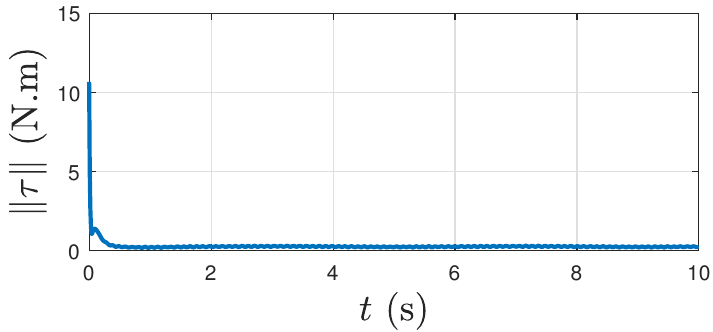
Figure 9. Magnitude of control torque versus time.